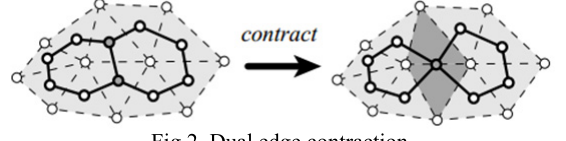
Fig.2. Dual edge contraction